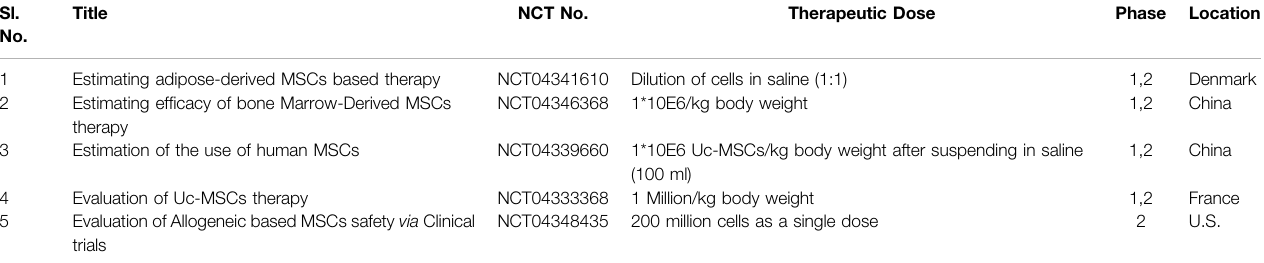
TABLE 8 | Running clinical trial studies for validation of Mesenchymal Stem Cell therapy (https://clinicaltrials.gov/ct 2/results). Sl. No.